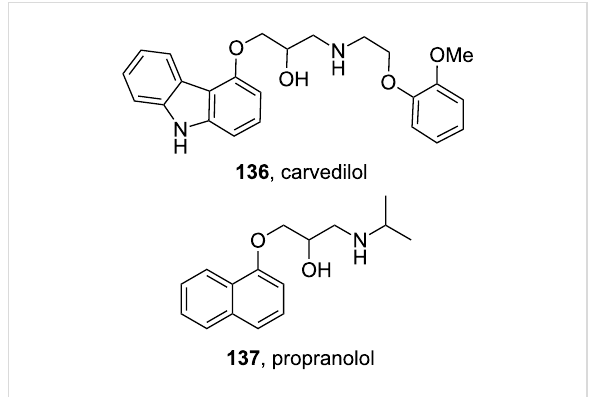
Figure 4: Structures of carvedilol 136 and propranolol 137